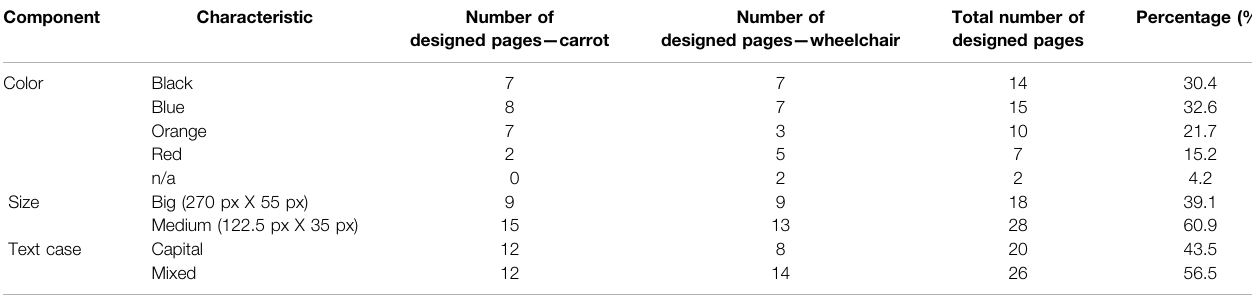
TABLE 3 | Characteristics of “ add to cart ” button selected by participants.